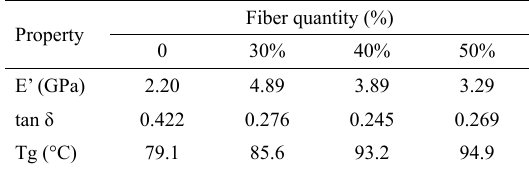
Table 3. DMA test results of Curaua fiber composites.